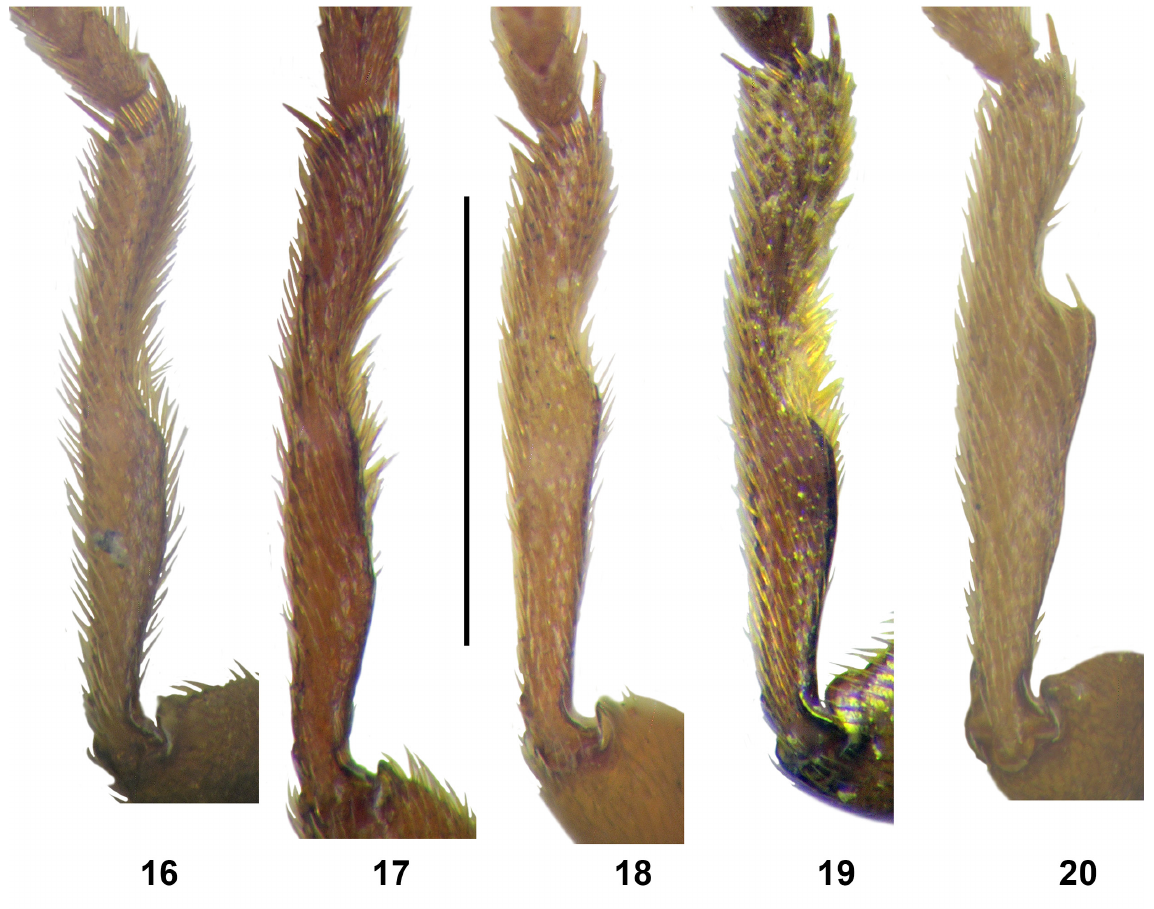
Figs 16–20. Speonemadus of the escalerai -group male protibia. 16 . Speonemadus algarvensis sp. nov. (Gruta do Vale Telheiro, Portugal). 17 . S. angusticollis (Kraatz, 1870) (Rute, Spain). 18 . S. bolivari (Jeannel, 1922) (Ardales, Spain). 19 . S. breuili (Jeannel, 1922) (Motillas, Spain). 20 . S. escalerai (Uhagón, 1898) (Jumilla, Spain). Scale bar = 0.5